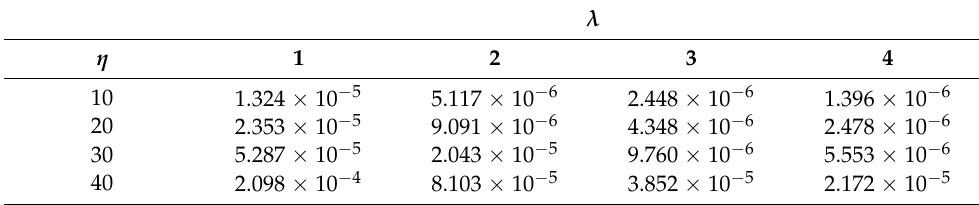
Table 6. Deflection values of the center point of the plate with different length-to-height ratios η